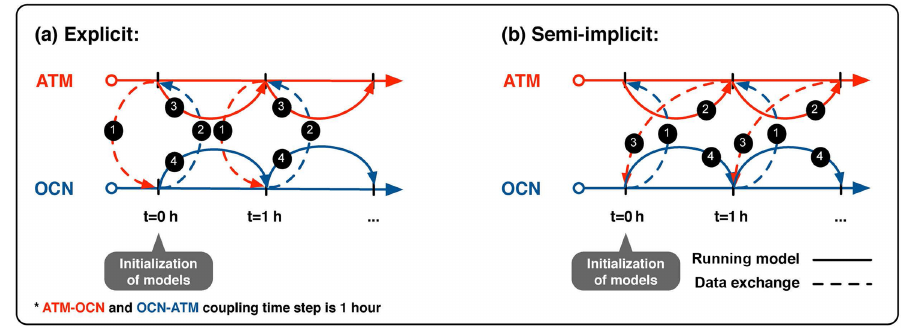
Figure 3. Schematic representation of (a) explicit and (b) semi-implicit model coupling between two model components (atmosphere and ocean). The numbers indicate the execution orders, which are initialized in each coupling